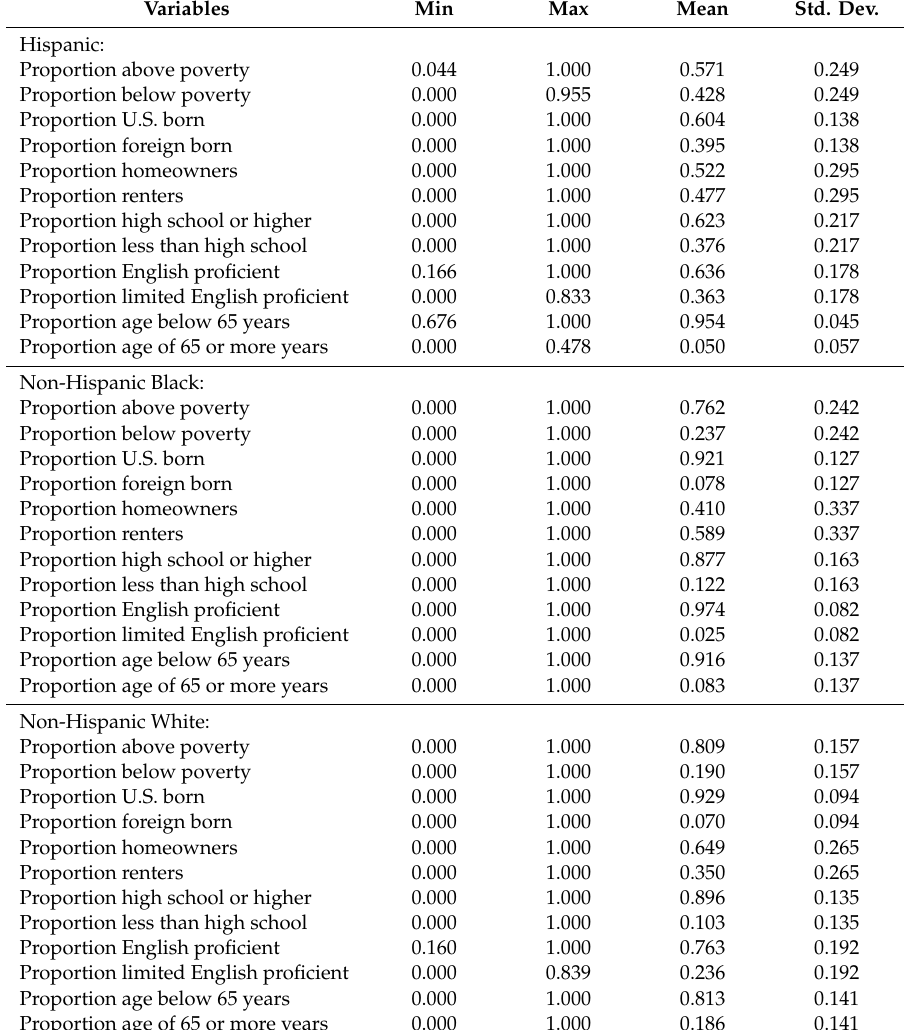
Table 2. Descriptive statistics for variables used in intra-categorical analysis (N = 784